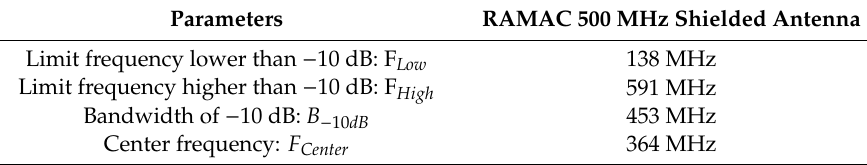
Table 1. System parameters of the RAMAC 500 MHz Shielded Antenna system used for investigation purposes